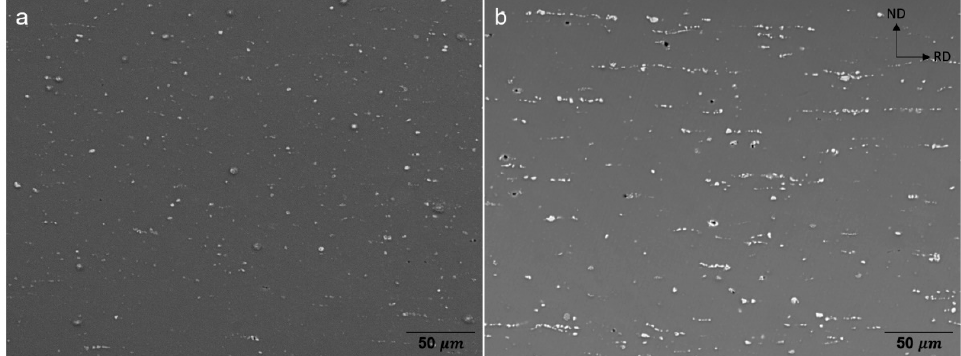
alloy sheets indicated by yellow arrows inserted in Figure 5.